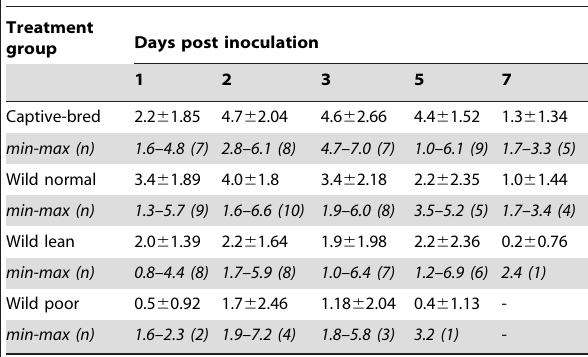
Table 1. Group mean daily ( 6 1 SD) viral genome load (log 10 GEC/140 m l swab sample fluid) for mallards inoculated with LPAIV H5N9.